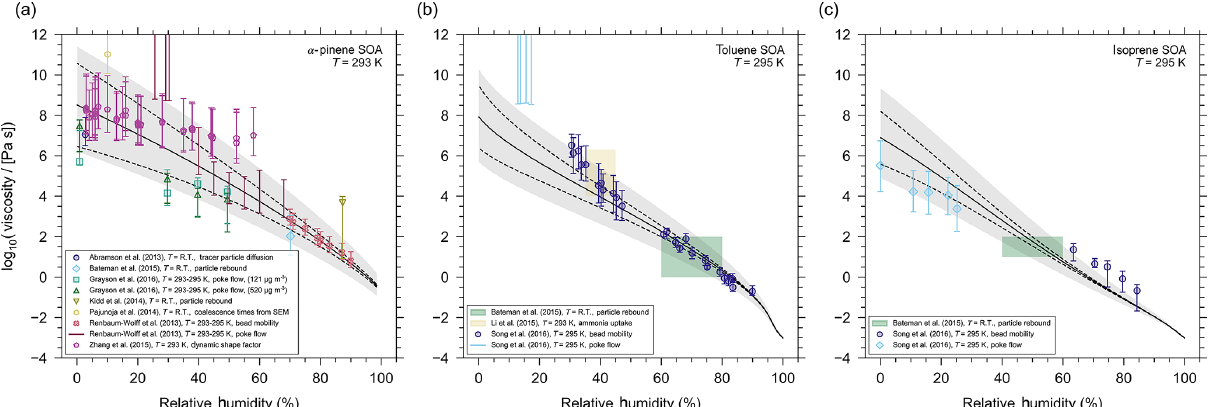
Figure 7. AIOMFAC-VISC mixture viscosity predictions (solid line) for (a) α -pinene SOA at T = 293K, (b) toluene SOA at T = 295K, and ( c ) isoprene SOA at T = 295K. The dashed lines represent the model sensitivity and the grey shaded regions represent a 5% uncertainty in estimated T g values. The markers and colour shaded regions represent experimental data obtained by different methods (see legend). T = R . T . indicates that the measurements were taken at room temperature ( ∼ 293 ±